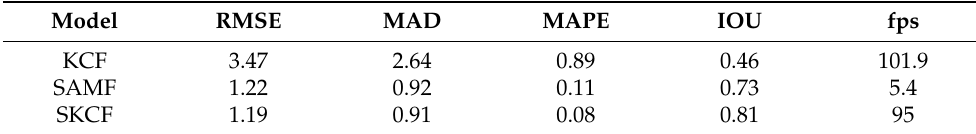
Table 3. Statistical metrics for varied ship trackers for video